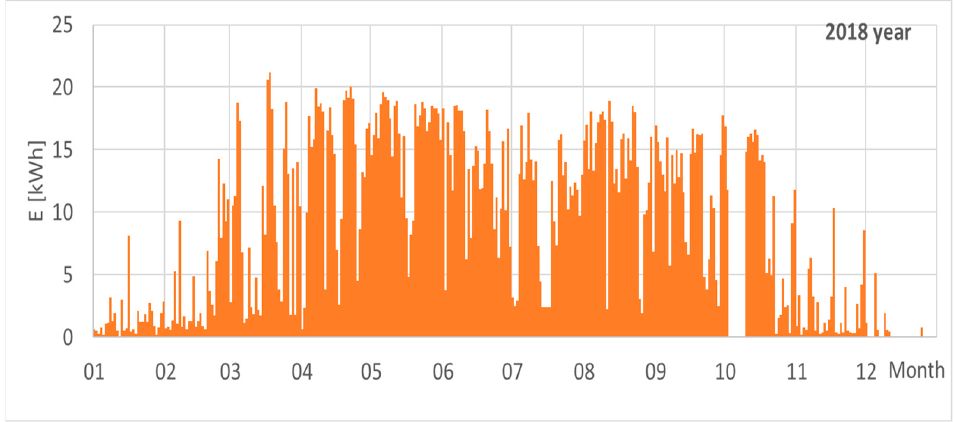
Figure 16. Daily energy generation by PV1 section in 2018 (own measurement data).